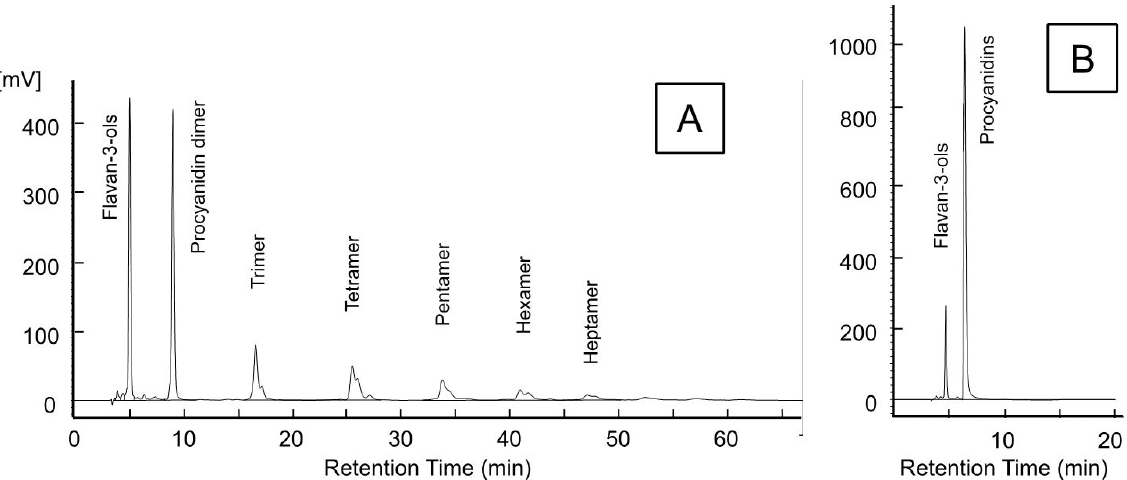
Figure 1. Normal-phase high-performance liquid chromatography profiles that were detected with a fluorescence emission of the ‘Fuji’ apple extract without peel by a ( A ) conventional and a ( B ) rapid quantitative methods. Analysis of flavan-3-ols and procyanidins by the conventional normal-phase chromatography ( A ) was performed by the method of Obara et al.